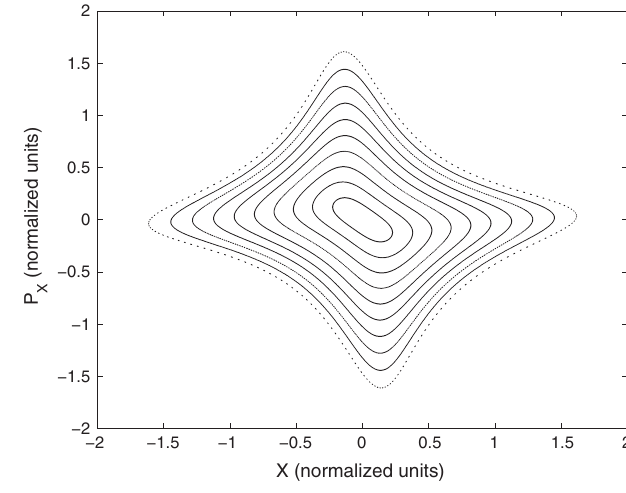
FIG. 3. 1D phase space.